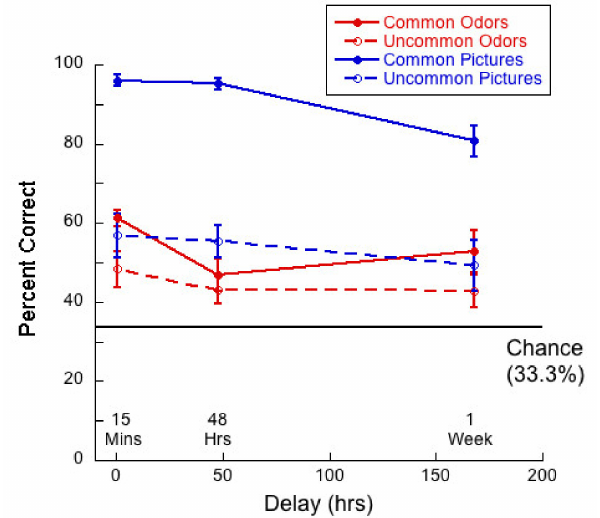
Figure 8. Percent correct as a function of delay for each of the four test conditions. Because there were three possible responses (“Odor 1”, “Odor 2” or “neither”), the chance was 33.33%. There were 22 participants in the 15-min delay condition, 19 at 48 h and 14 at 1 week.